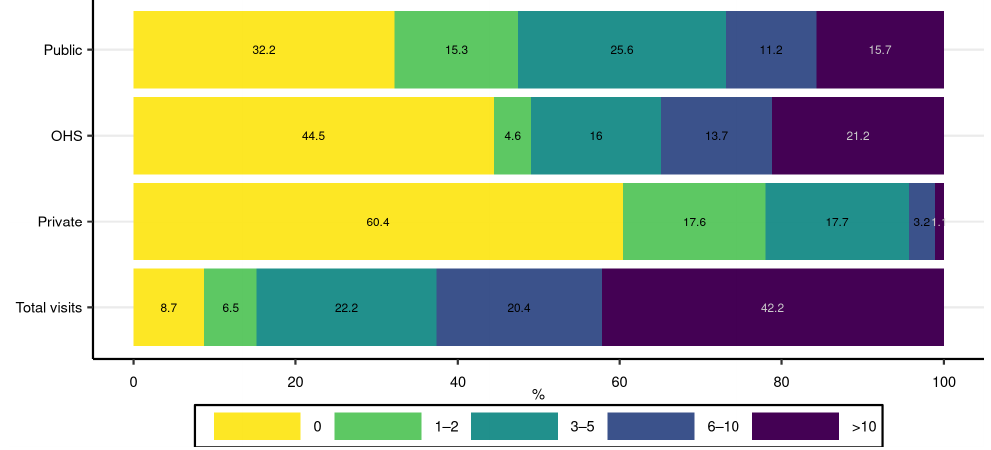
Figure 1. Proportion of residents with respect to number of medical visits in different sectors. Note that a resident may have medical visits in more than one sector. Figure 2 shows the proportion of residents with at least one dentist visit with respect to the number of medical visits, divided by sectors. The higher the number of medical visits, the more likely it was also to have a dentist visit during the examined two-year period. Of residents who had, in total, more than ten medical visits, 70% also had at least one dentist visit. Among those who had no medical visits, slightly over 40% had a dentist visit. However, as shown in Figure 1 above, the proportion of residents with no medical visits was small. The probability of dentist visits increased clearly with an increasing number of private medical visits, while the increase in the number of public or OHS medical visits was more moderate.